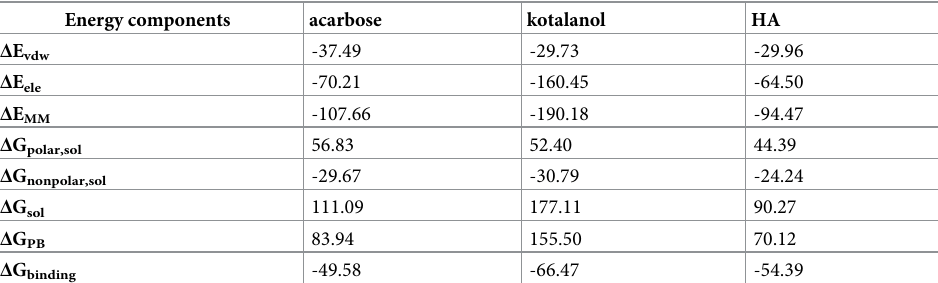
Table 4. The MM-PBSA score for three complexes (kcal /mol). Energy